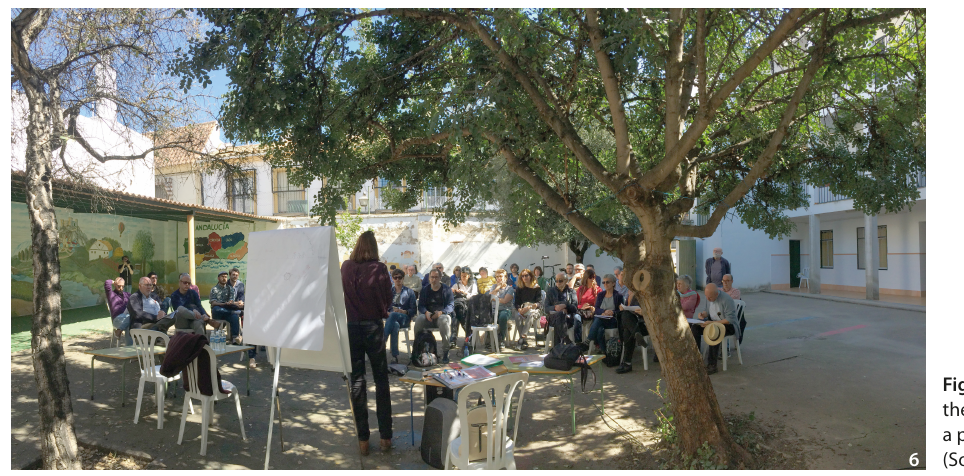
Figure 6 Meeting of the ‘Right to the City’ Forum in a courtyard of a public building on March 2019 (Source: the